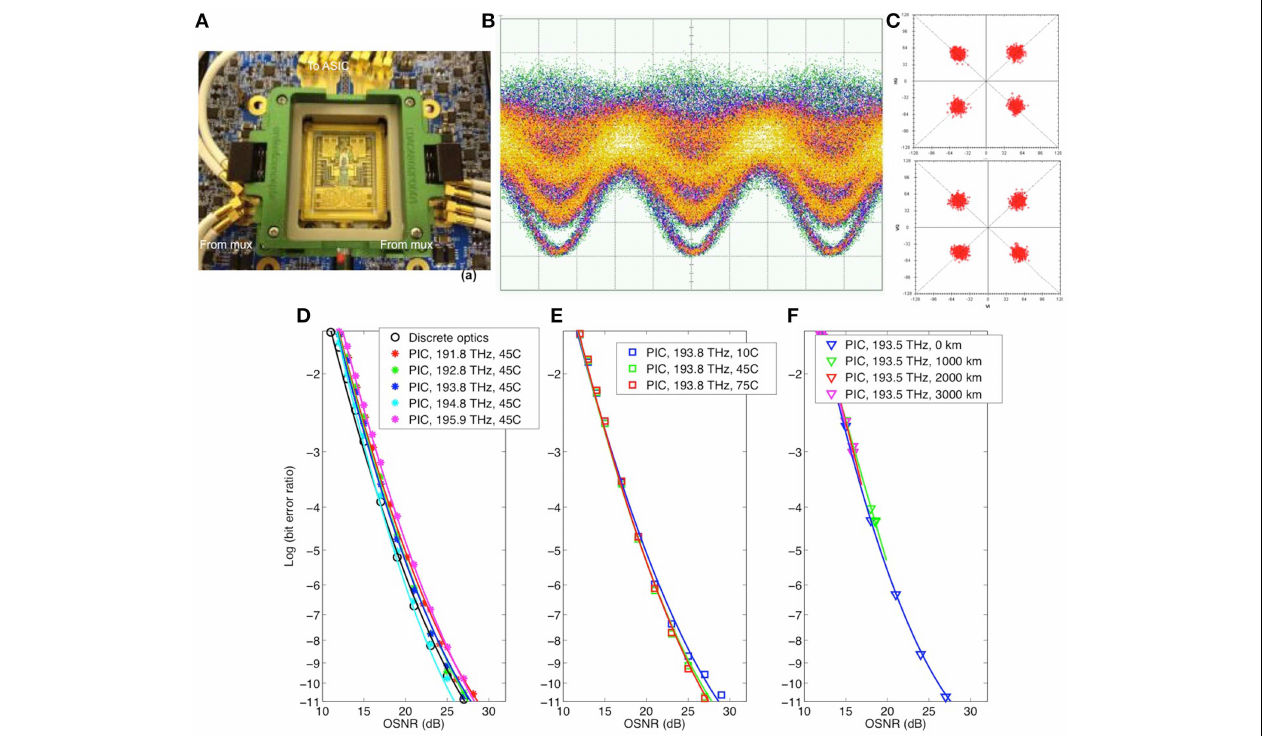
FIGURE 26 | (A) Measurement setup, (B) measured 30-Gbaud eye diagram for DP-QPSK, (C) real-time-processed constellations at 120 Gb/s, and (D–F) bit-error rate vs. OSNR for various cases for the silicon photonics single-chip coherent transceiver in an optical loop back configuration.